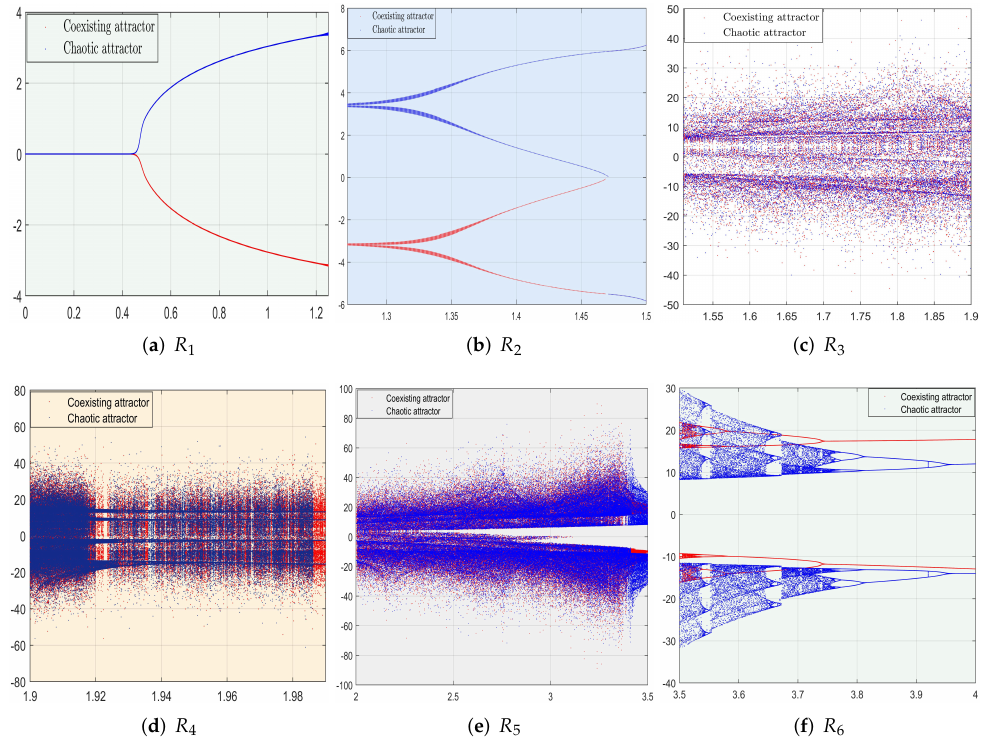
Figure 7. Bifurcation diagram partitioned in subregions (bifurcation leading to